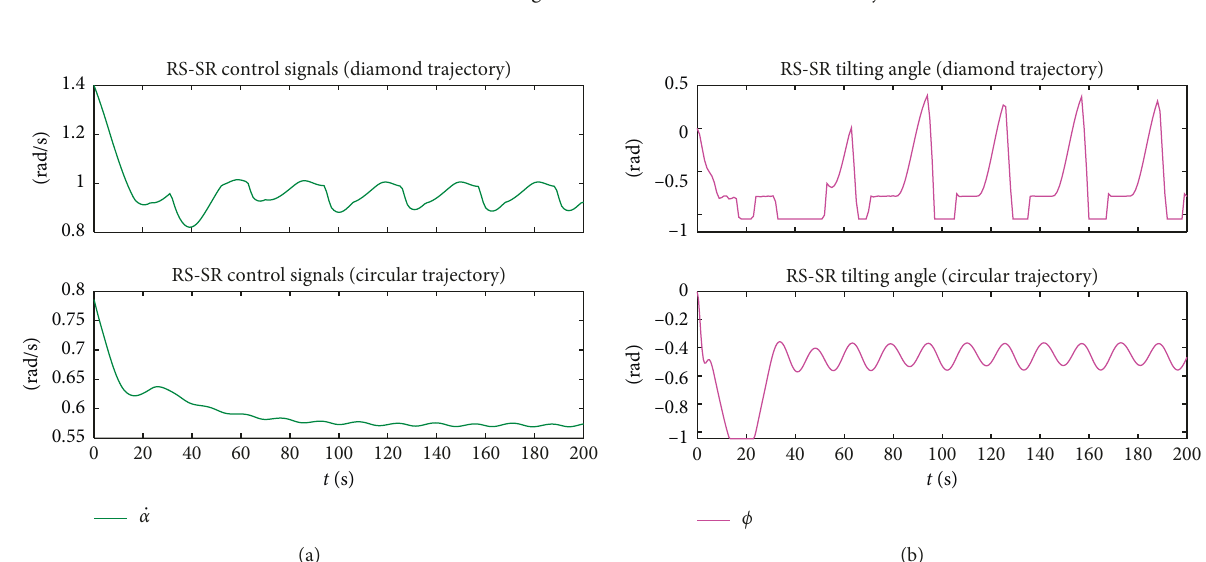
Figure 11: RT-SR control signals for smooth and nonsmooth trajectories.